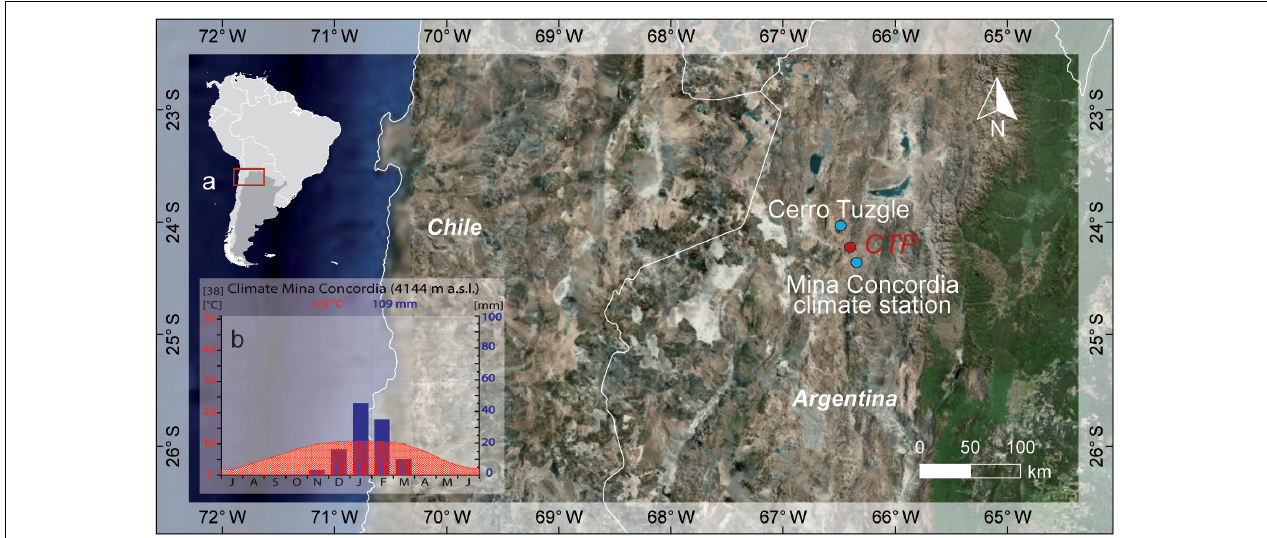
FIGURE 1 | (a) Location of the CTP study area, Cerro Tuzgle and Mina Concordia climate. (b) Climate diagram Mina Concordia [data source: Mina Concordia (1950 – 1990; 1966 and 1970 are missing) data based on Bianchi et al., 2005]. Map data source is GLCF World Data and DGM-GTOPO30.